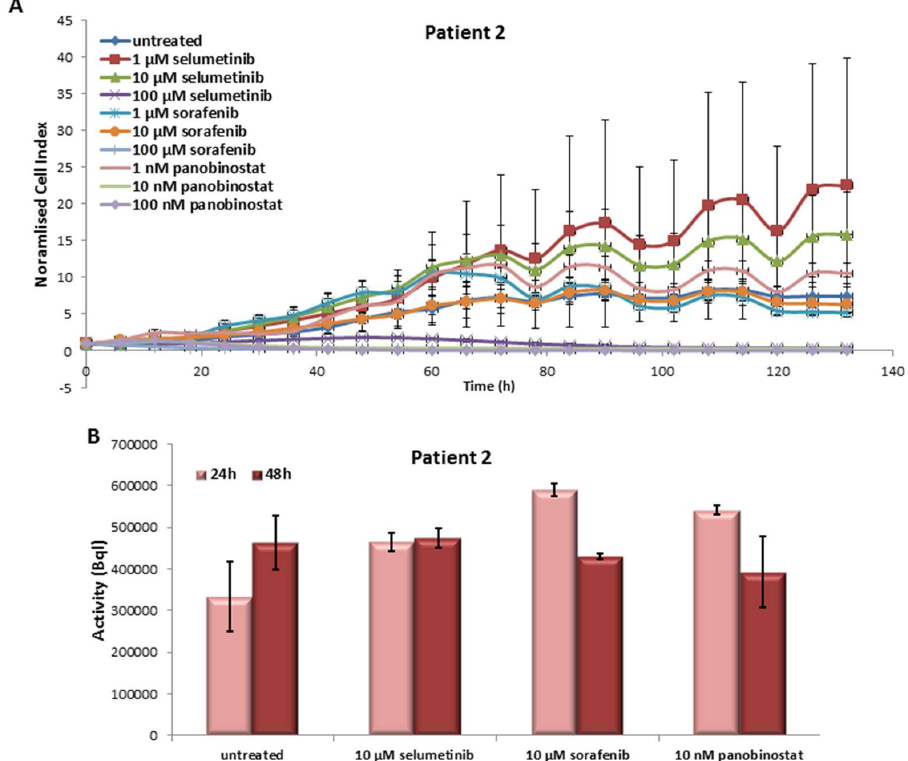
Figure 3. Effects of selumetinib, sorafenib and panobinostat on cell viability and RAI-U. Real time cell viability of PDTT (ATC—Patient 2) cells treated with 1 to 100 µM selumetinib and sorafenib and 1 to 100 nM panobinostat ( A ). RAI-U after 24 and 48 h of treatment with 10 µM selumetinib, 10 µM sorafenib and 10 nM panobinostat ( B ). Shown are means of experiments performed in triplicates ± SD ( A )/SEM ( B ).